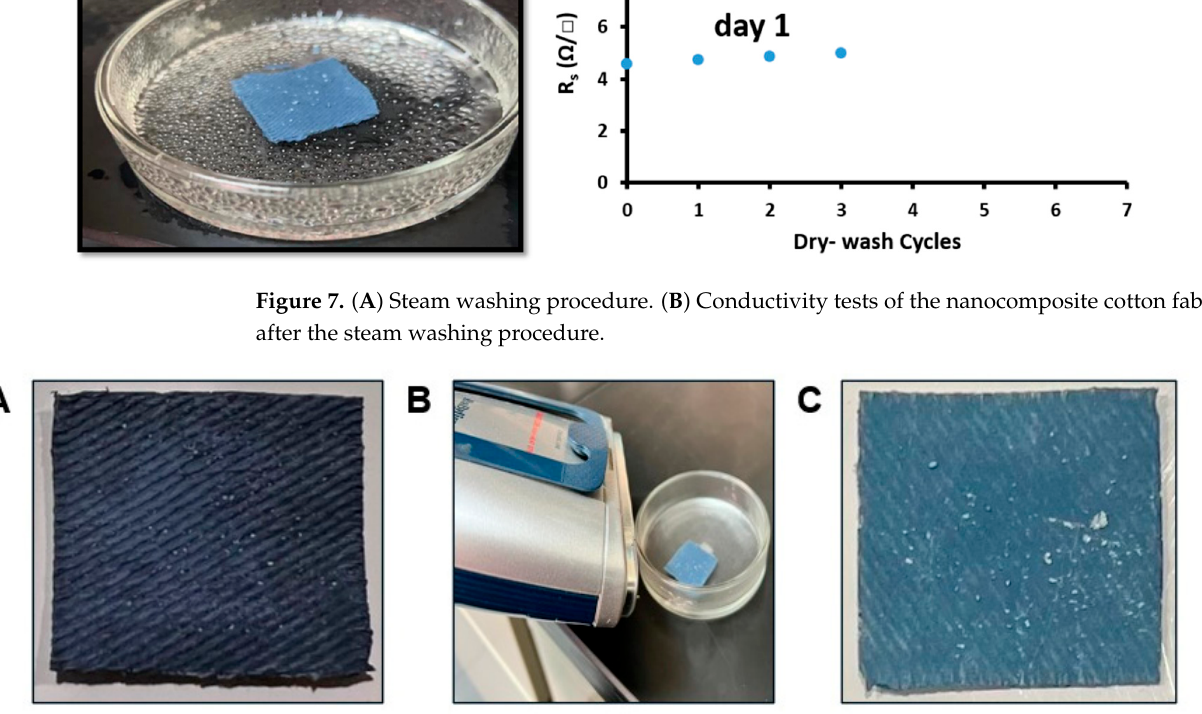
Figure 8. The image of the cotton fabric before washing ( A ), during washing ( B ) and after washing ( C ).